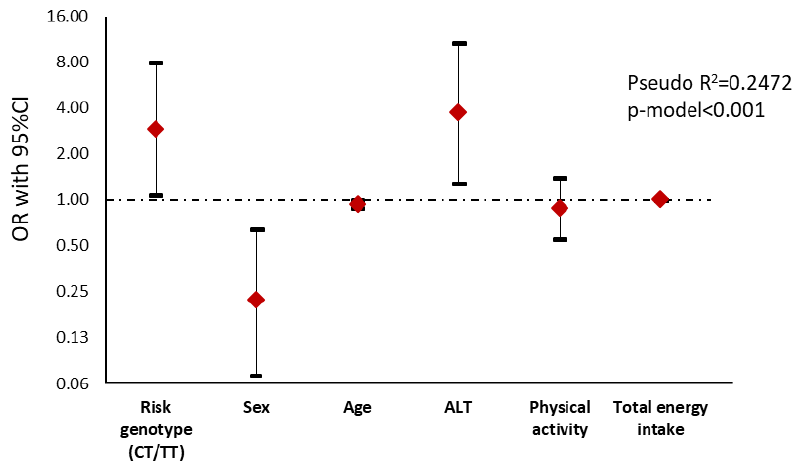
Figure 1. Graphical display of the Odds Ratio (OR) (95% confidence interval) of the logistic regression analysis between Fatty Liver Index and genotype in NAFLD subjects. Fatty Liver Index is the dependent variable and was dichotomized according to the median (0 = FLI < 80 vs. 1 = FLI ≥ 80). Notice that the y -axis is on a log scale. ALT, Alanine Aminotransferase.